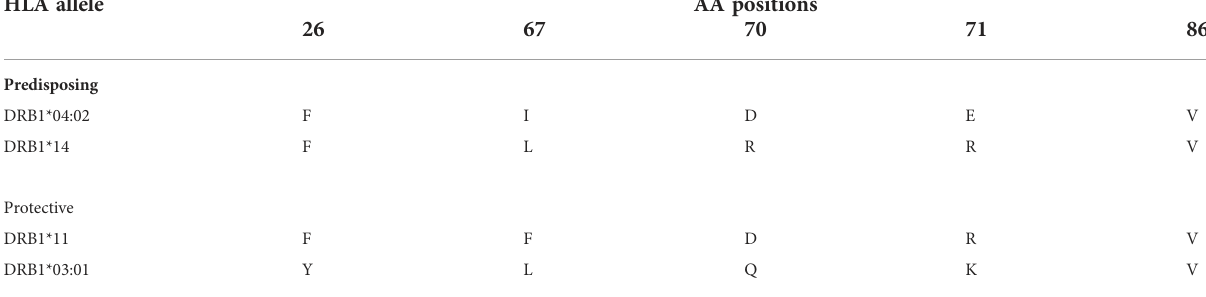
TABLE 4 Amino acid positions in HLA-DRB1 alleles associated with pemphigus vulgaris in the Bulgarian population. HLA